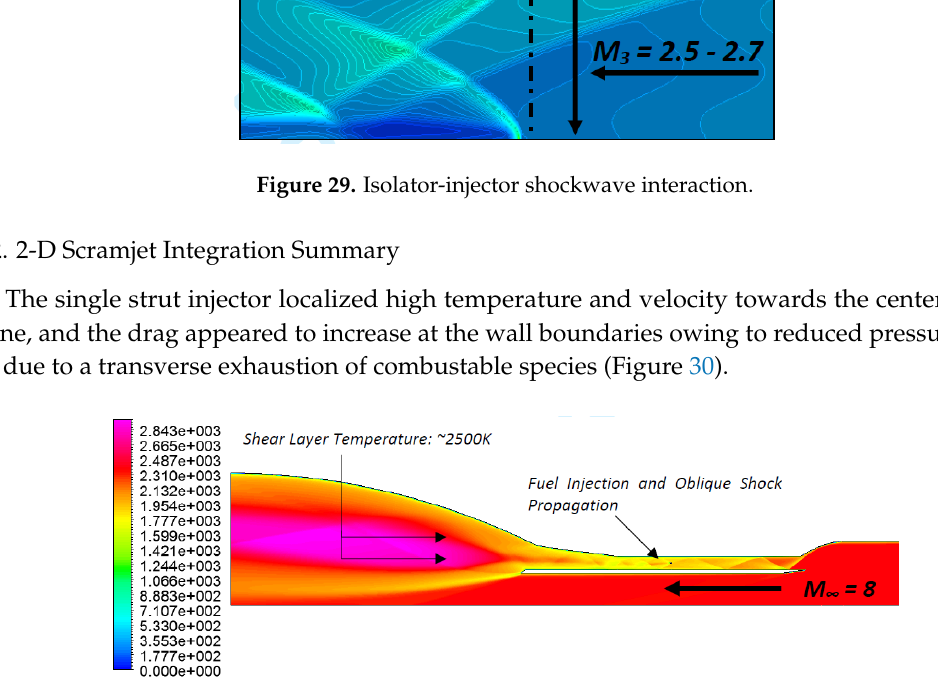
Figure 30. Velocity (in m/s) contour for single strut injection of a full scramjet engine in 2-D.